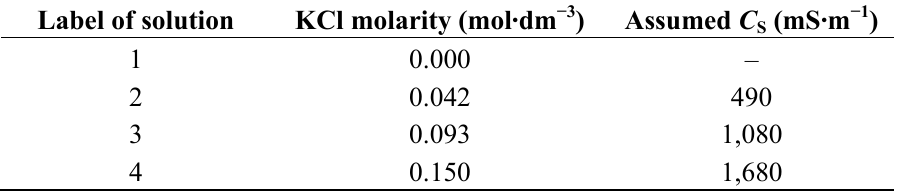
Table 2. Parameters of KCl solutions applied for wetting the measured material (values at temperature 21 °C). Assumed (cid:1829) values were calculated from molarity [16] and confirmed (cid:3020) by